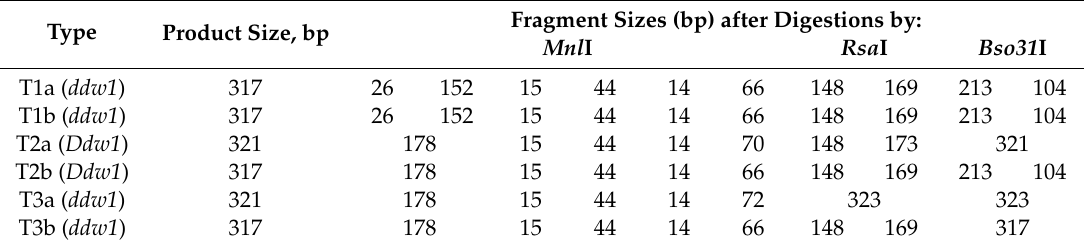
Table 1. Ddw1 genotype and DNA fragment sizes (in bp) after digestion of REMS1218 PCR products by an excess of the restriction endonucleases Mnl 1, Rsa I, or Bso 31I. The fragments used for genotyping (“diagnostic fragments”) are highlighted by bold font; the smaller fragments are not essential for genotyping since they are out of the detection range in the agarose gel electrophoresis. Abbreviation T1a, T1b, etc. are the same as in Figure